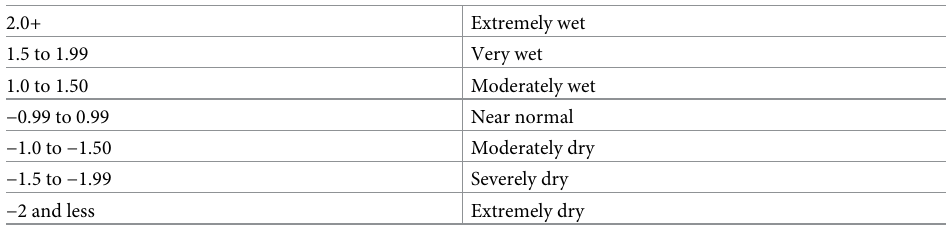
Table 3. Drought severity based on SPI values